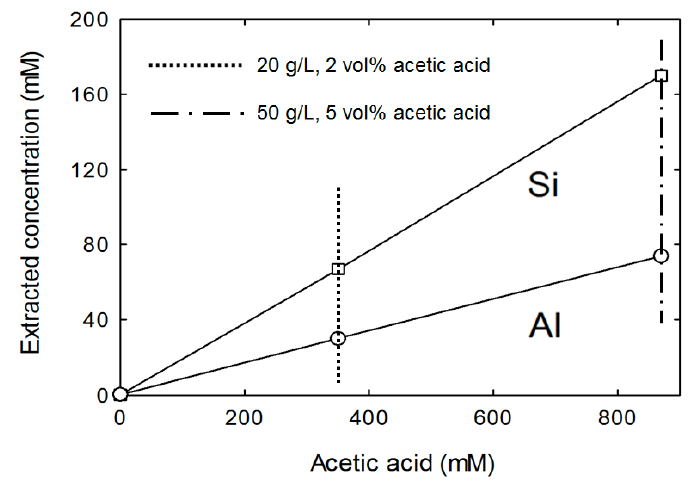
Figure 3. Concentrations of extracted Si and Al as functions of acetic acid concentration.